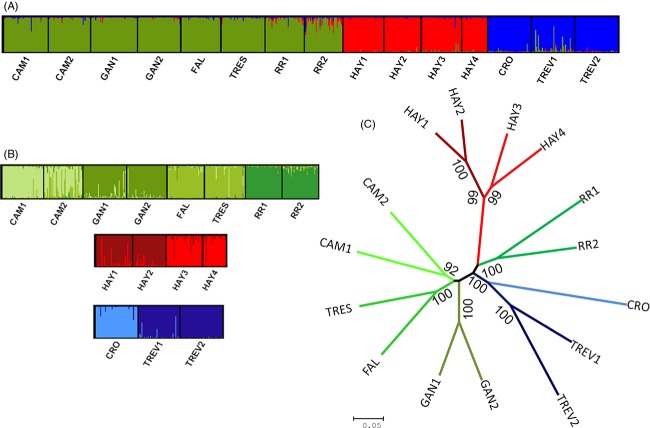
(A and B) Hierarchical STRUCTURE analyses showing estimated proportions of the coefficient of admixture of each individual's genome that originated from population K. (A) Primary STRUCTURE plot of all populations (K = 3). (B) From left to right; in green: hierarchical plot, where K = 4; in red: hierarchical plot, where K = 2; in blue: hierarchical plot, where K = 3. (C) Neighbor-joining phenogram, based on Cavalli-Sforza and Edwards chord distance (DCE) showing the relationships between 15 populations of brown trout. Bootstrap values (% based on 1000 replicates) are show next to relevant branches; only bootstraps >90% are shown in the figure. Colors for each population match those presented in A and B.